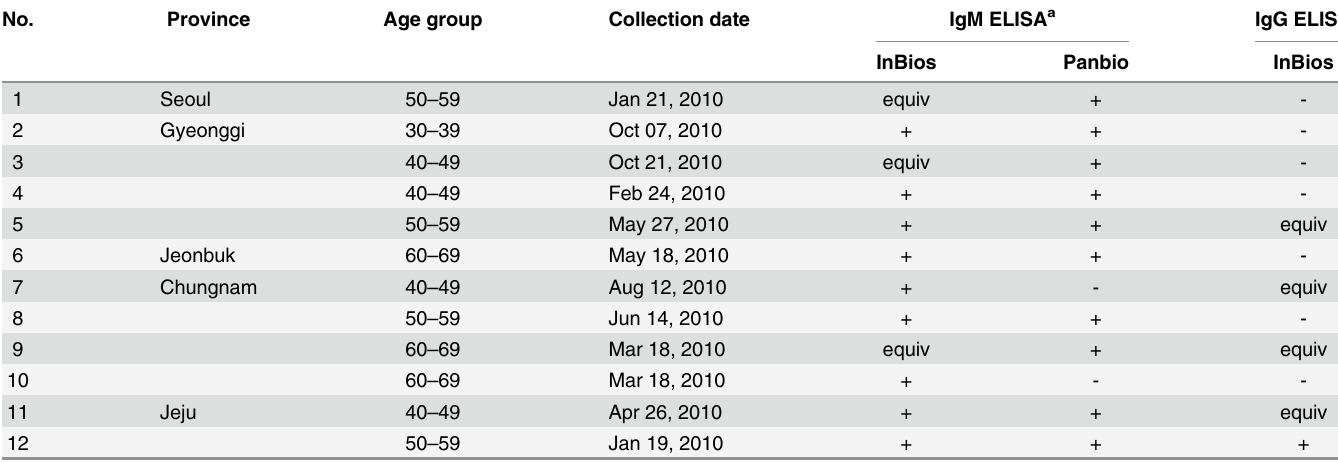
Table 6. Evidence of recent infection by Japanese encephalitis virus (N = 549).